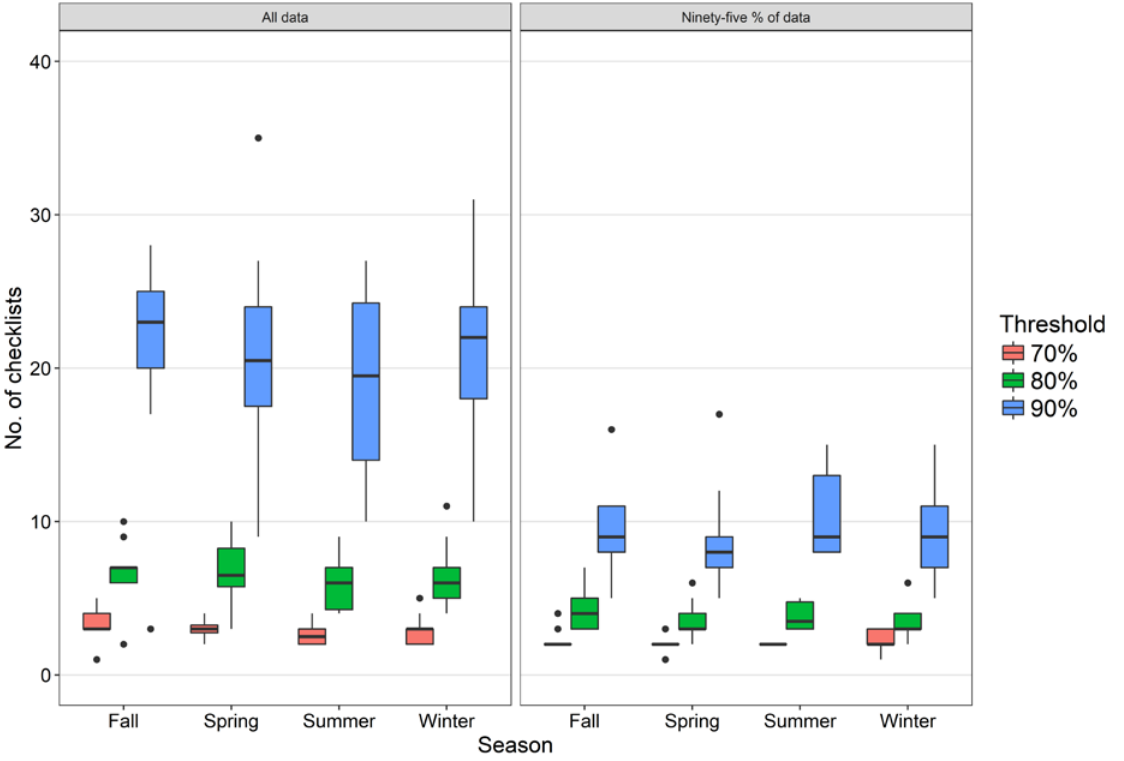
Figure A2.2. The difference among seasons and minimum number of checklists for species